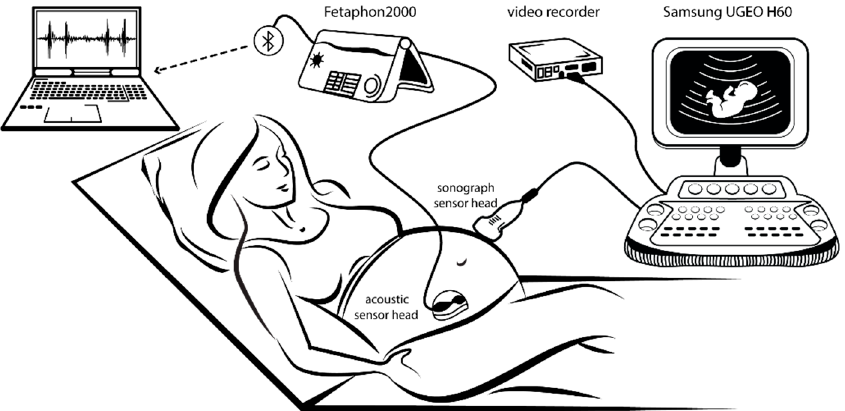
Figure 1. On the left side of the synchronous measurements set-up, it is visible that the phonographic (acoustic) sensor head is attached to the Fetaphon2000 monitor and its data are transferred via Bluetooth to a laptop. On the right side, the sonograph sensor head is attached to the ultrasound monitor used for validation only. The ultrasound measurements are recorded by a video recorder.